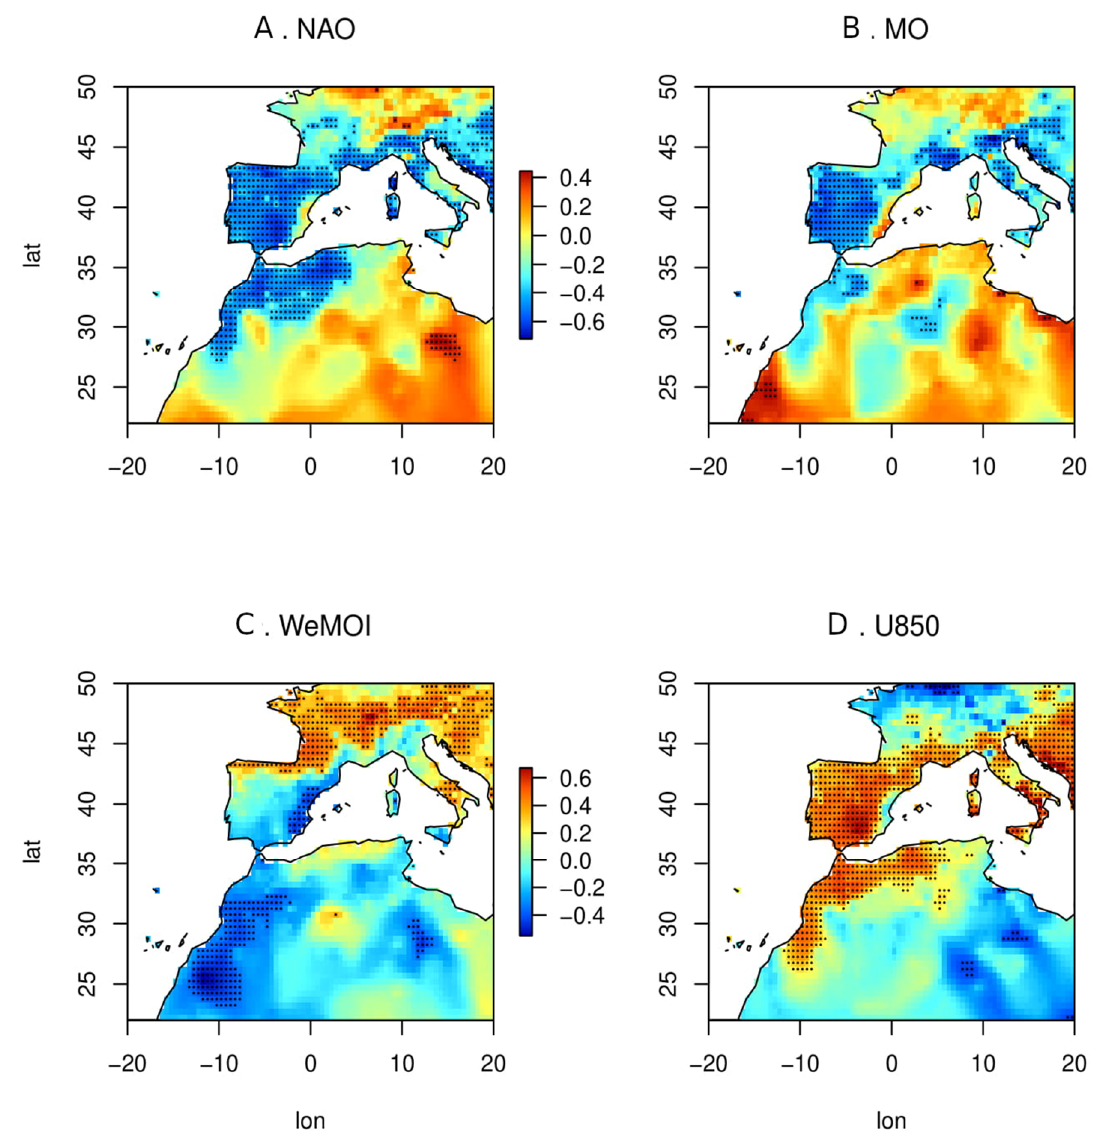
Figure 5. Pearson’s correlation coefficients between observed precipitation (Delaware) [43] and ( A ) NAO, ( B ) WeMO, ( C ) MO, and ( D ) U850 for the period 1979–2005. Dotted areas represent significant correlations at 95% confidence interval.